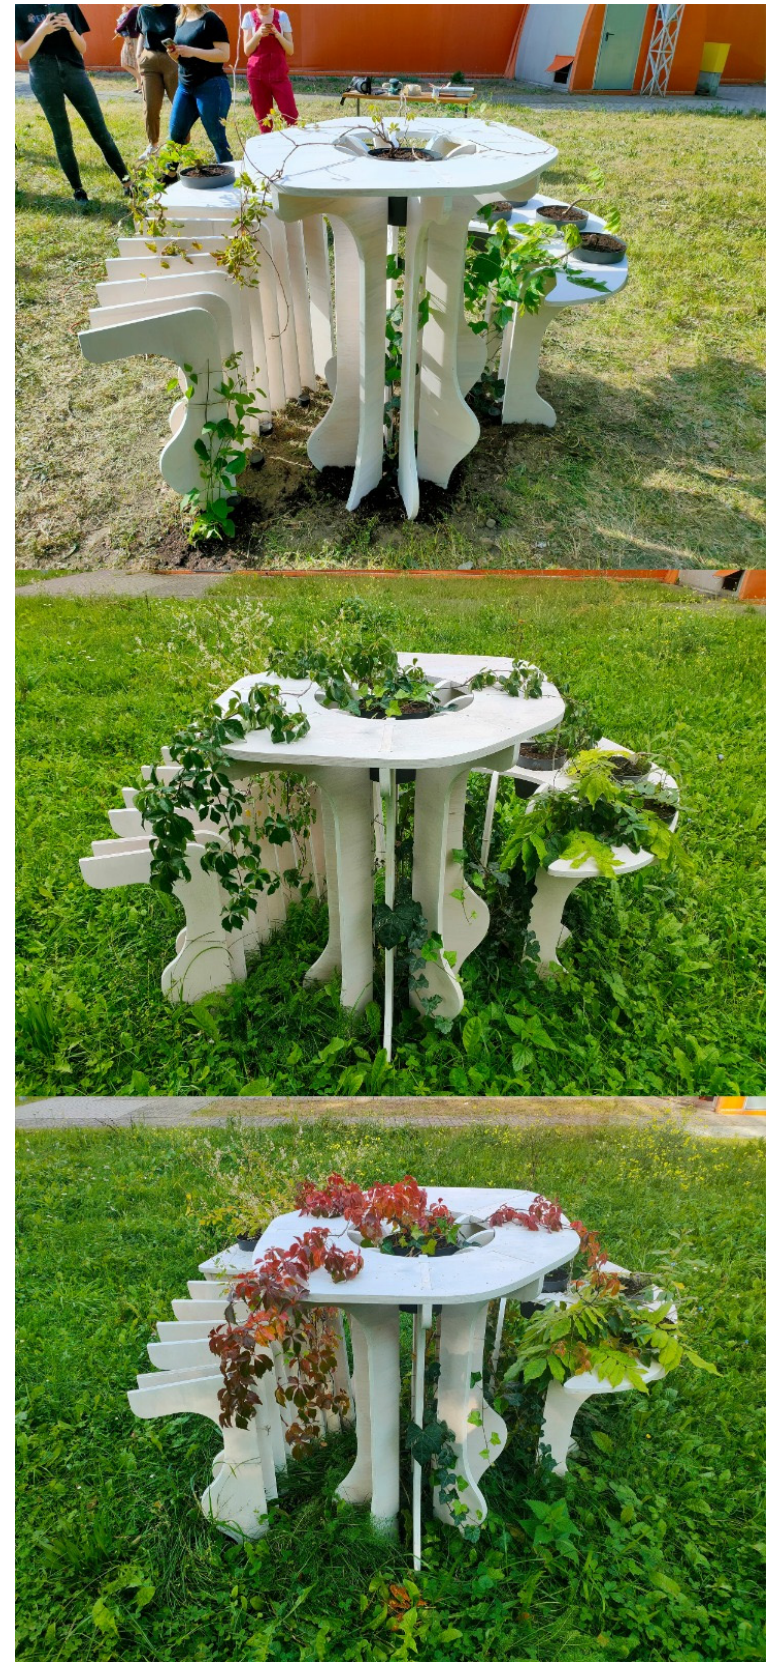
Figure 13. Growth of plants through the seasons (spring, summer, and fall).